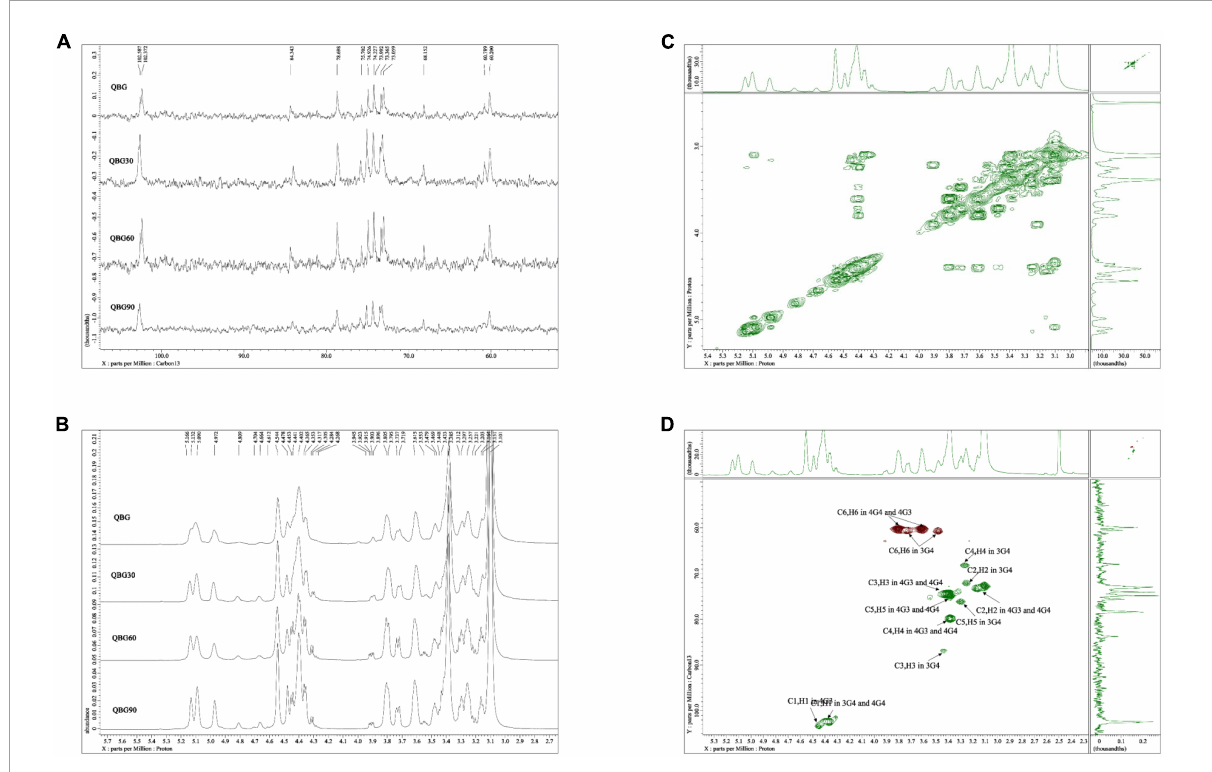
FIGURE1 Nuclear magnetic resonance spectra: (A) 13 C NMR spectrum of Qingke β -glucan samples, (B) 1 H NMR spectrum of Qingke β -glucan samples, (C) 1 H– 1 H COSY spectrum of QBG30, and (D) HSQC spectrum of QBG30.